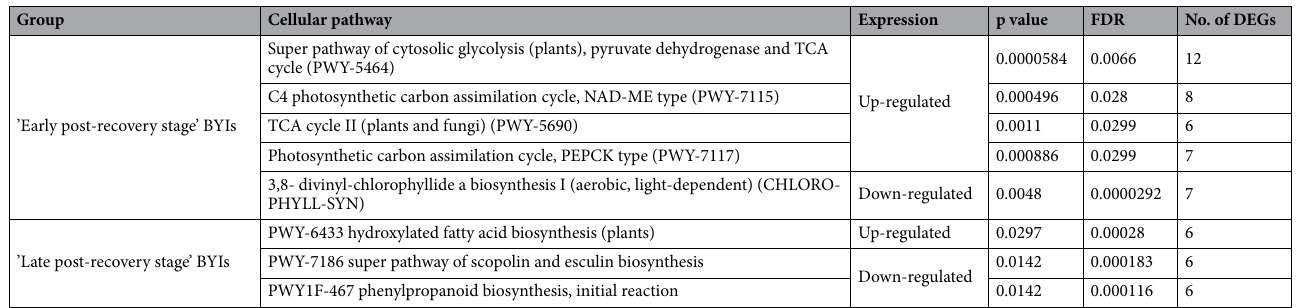
Table 2. Pathway enrichment analyses of differentially expressed genes in bright yellow islands of early and late post-recovery stages compared to the corresponding dark surrounding tissues. BYIs bright yellow islands, FDR false-discovery rate, DEGs differentially expressed